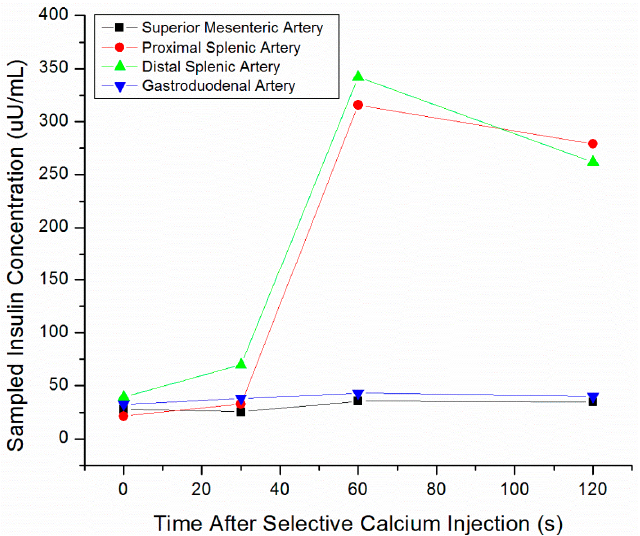
Figure 5. SACST data from pancreatic tail insulinoma. Hepatic venous insulin was markedly elevated after stimulation of either the proximal or distal splenic arteries.